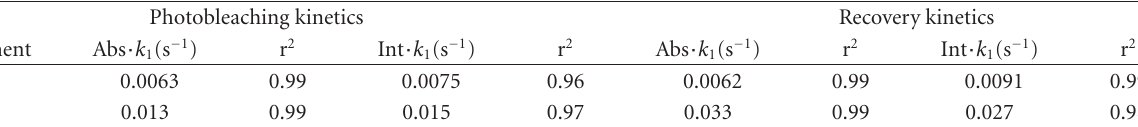
Table 1: Photobleaching and recovery kinetics of a typical UV-activated oxygen indicator.